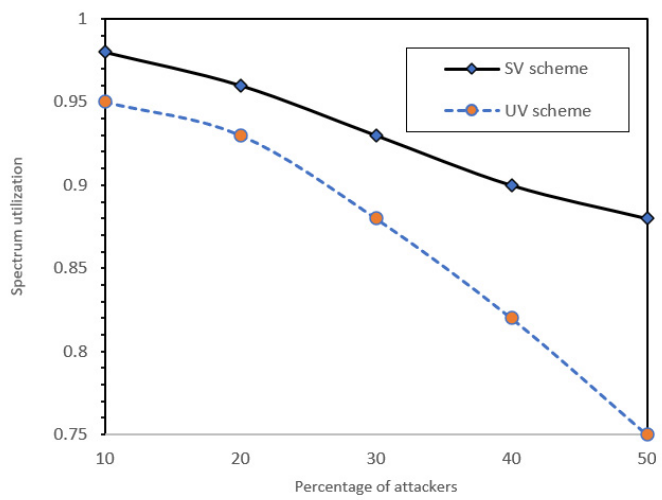
Figure 4. Comparison of utilization under various percentages of attackers.